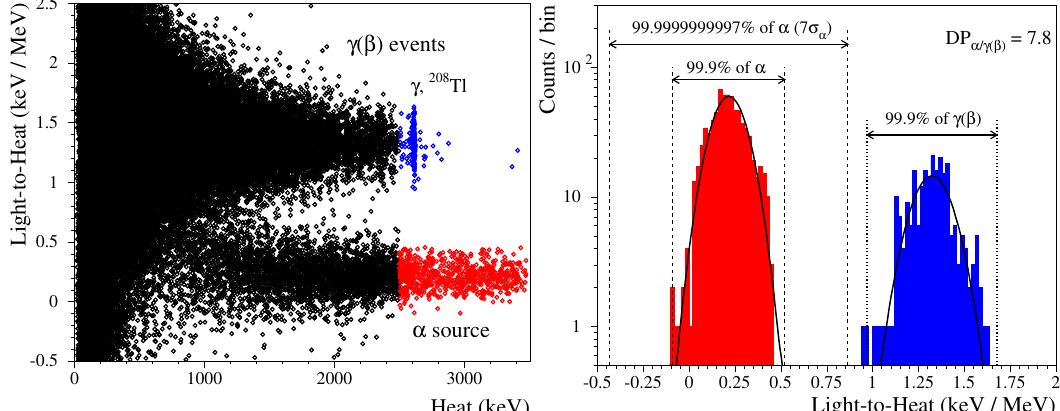
Figure 3. Left panel : Heat energy distribution of the light-to-heat parameter, L / H , of nuclear events detected by a scintillating bolometer based on a 379 g 100 Mo-enriched zinc molybdate crystal (enrZMO-t in [74]) and a thin Ge bolometric light detectors (LDs). first The detector was operated deep underground over 78 h of γ calibration and 593 h of background measurements. The crystal has been also irradiated by a 238 U/ 234 U α source, emitting α particles degraded in energy. The 2.5–3.5 MeV events, marked in blue and red, are used to illustrate the discrimination power parameter (see text). Right panel : Distributions of the L / H parameter of events selected from the data (shown in the left panel) in the 2.5–3.5 MeV energy interval [74]. Both distributions are fitted by Gaussian functions shown by solid lines. The intervals containing 99.9% of both event types and ± 7 σ range of the α band are indicated. The discrimination power is evaluated as DP α / γ ( β ) = 7.8 (see text for details). Right panel is reprinted with permission from [74]. Creative Commons License CC BY